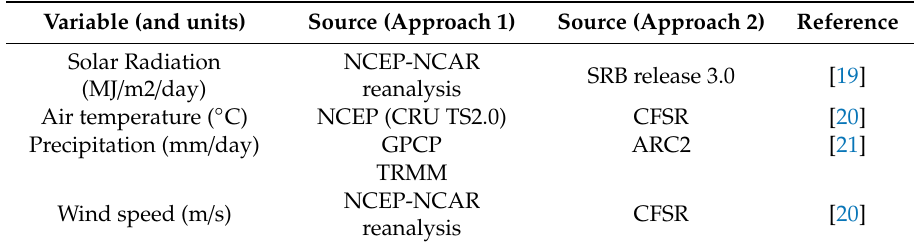
is used for downscaling the NCEP-NCAR reanalysis coarse data to a finer